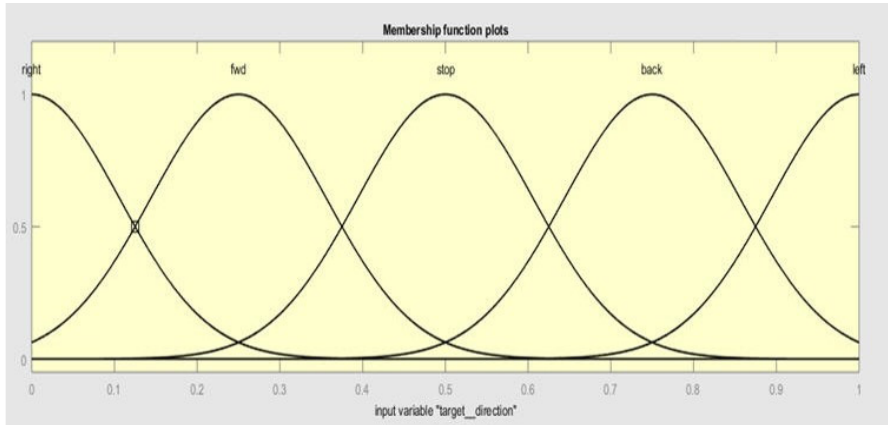
Figure 7. Membership functions of input 3 (target direction).